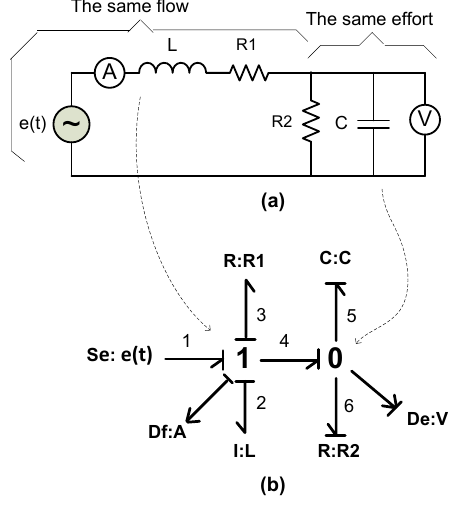
Figure 8. Example of an electrical system ( a ) and its bond graph model ( b